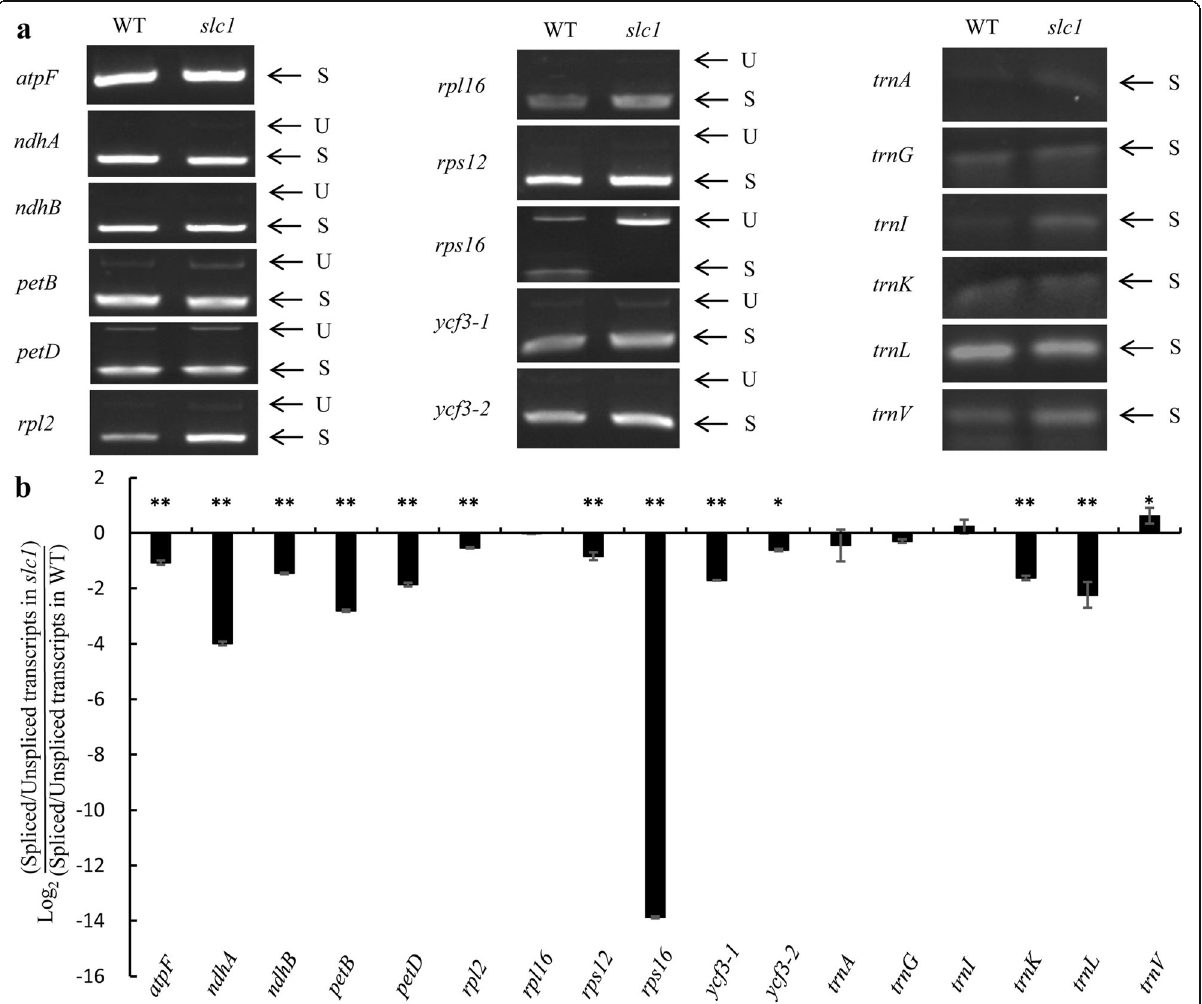
Fig. 6 Splicing analysis of chloroplast intron-containing transcripts in the wild type and slc1 mutant leaves at the third-leaf stage. a RT-PCR analysis of 18 intron-containing genes in the wild type and slc1 mutant leaves. U, Unspliced transcripts; S, Spliced transcripts. b Splicing efficiency analysis of chloroplast intron-containing transcripts in the wild type and slc1 mutant leaves. psbA was used as internal control, and relative transcript levels were analyzed using the 2 - ΔΔ CT method (Livak and Schmittgen 2001). Three biological replicates were performed. Values indicating the log 2 ratios of spliced to unspliced transcripts in the slc1 mutant compared to the corresponding values in the wild type. Error bars are SDs. The asterisks indicate statistical significance between the wild type and slc1 mutant, as determined by Student ’ s t-test (* P < 0.05, ** P <